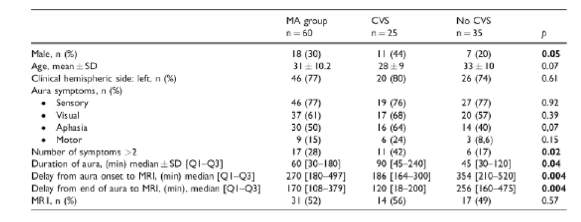
Table 1 (abstract P61). Clinical characteristics of the entire migraine aura (MA) group and acording to the presence of the cortical veins sign (CVS). Statistically significant results in